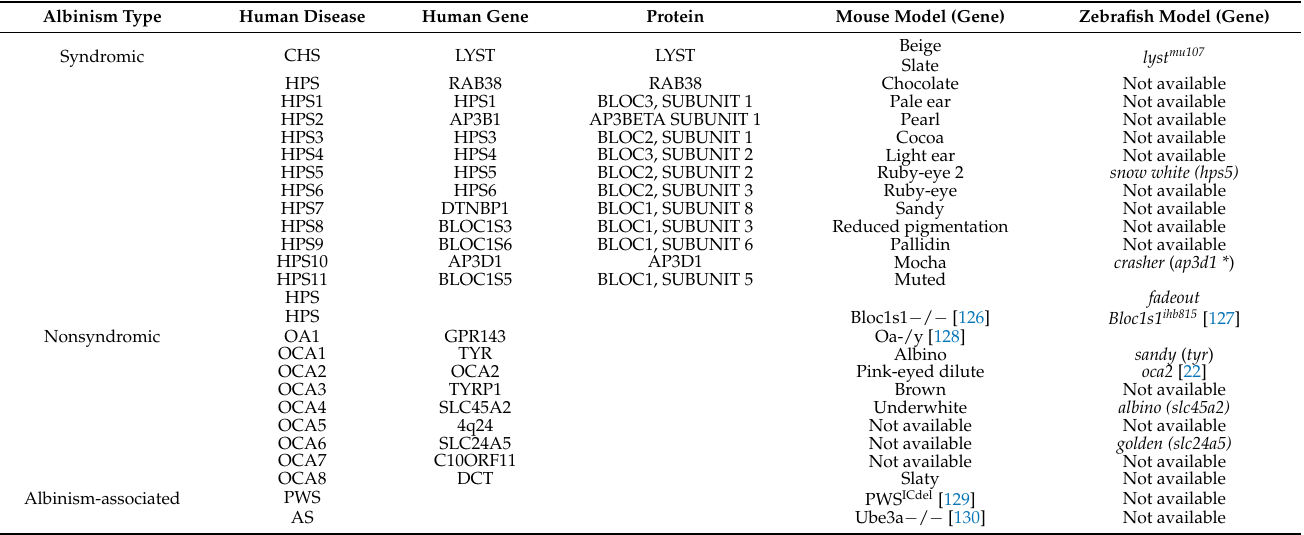
Table 1. Types of albinism disorders with some relevant mouse and zebrafish models. Albinism